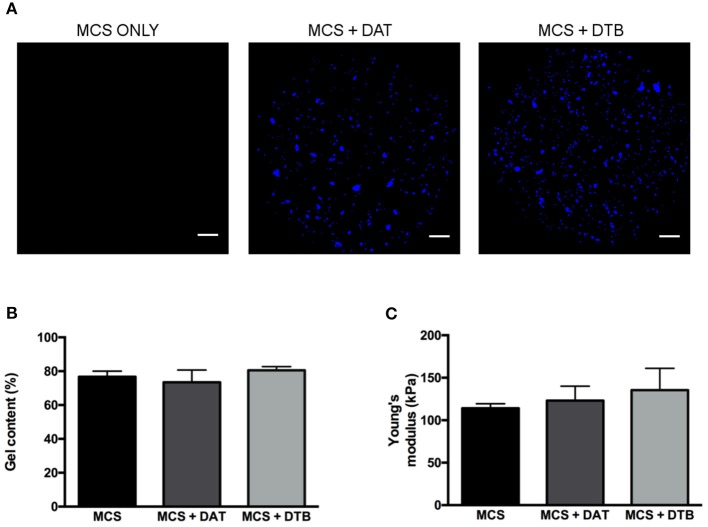
Confirmation that the MCS, MCS+DAT and MCS+DTB hydrogel systems exhibited similar bulk properties. (A) Confocal image analysis showing that the ECM particles (blue) were well distributed throughout the hydrogel phase. Scale bars: 1 mm. No significant differences were observed between the three hydrogel systems in terms of (B) gel content (n = 3 samples per group/trial, N = 3 trials) and (C) Young's moduli, measured under unconfined compression in PBS at 37°C (N = 5).